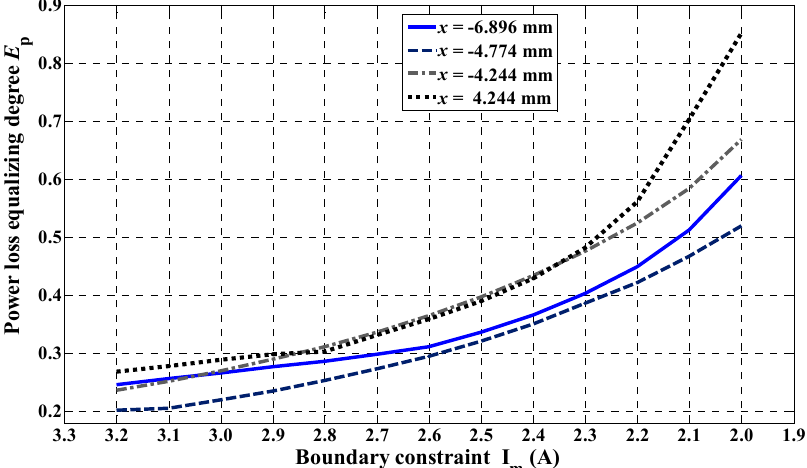
Figure 10. PLED varying trends while the boundary constraint I m is being gradually decreased from 3.2 A to 2.0